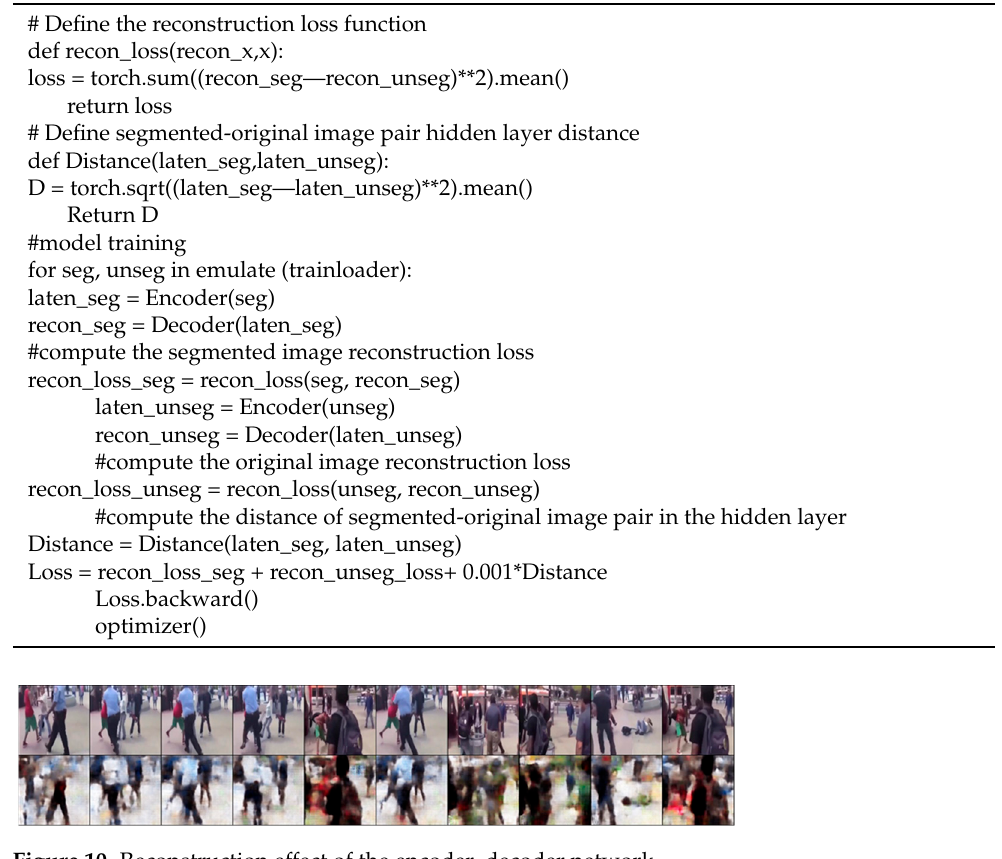
( b ) Figure 11. Frame differences for violent videos. ( a ) camera movement, ( b ) Camera fixation.